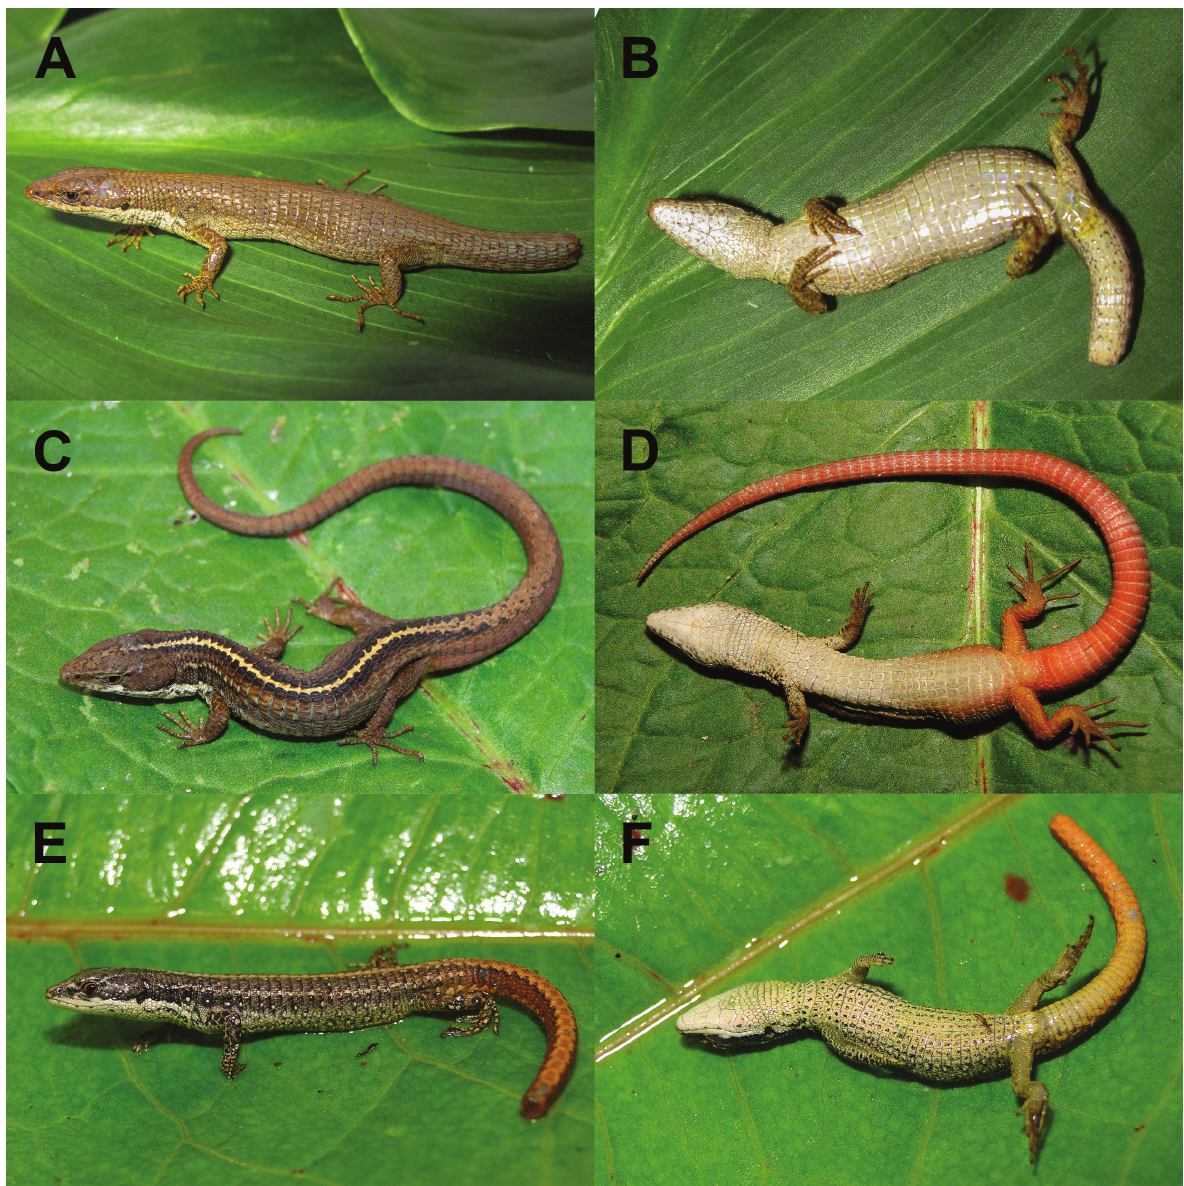
Figure 3. Paratypes of Selvasaura evasa sp. nov.: dorsolateral ( A ) and ventral ( B ) views of adult female CORBIDI 15118; dorsolat - eral ( C ) and ventral ( D ) views of adult male CORBIDI 18900; dorsolateral ( E ) and ventral ( F ) views of juvenile CORBIDI 19955. Photographs A, B by LYE and C–F by